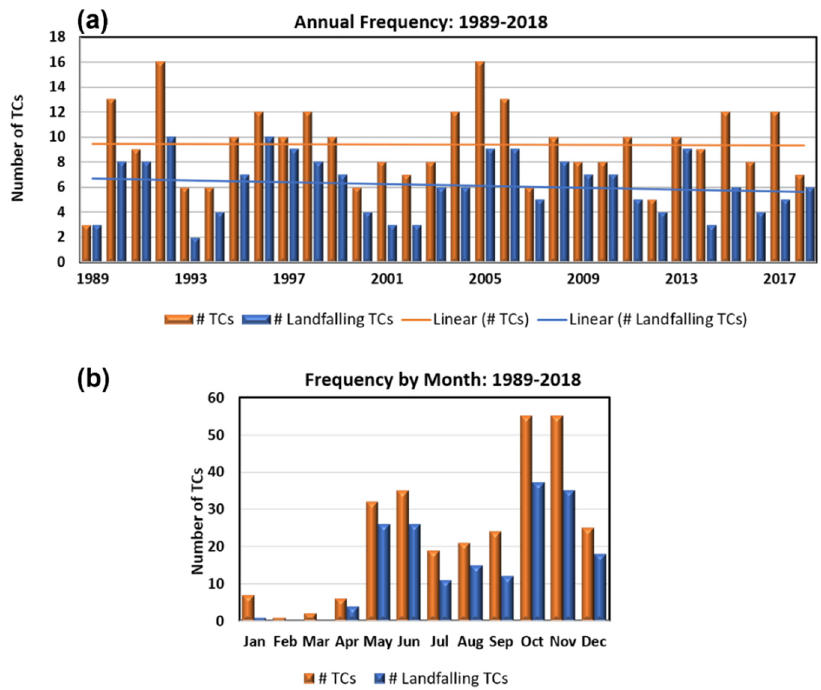
Figure 3. Histogram of the number of TCs that form (orange) and make landfall (blue) in the NIO from 1989–2018: ( a ) annual frequency and ( b ) by month. “#” refers to “number” in both panels.